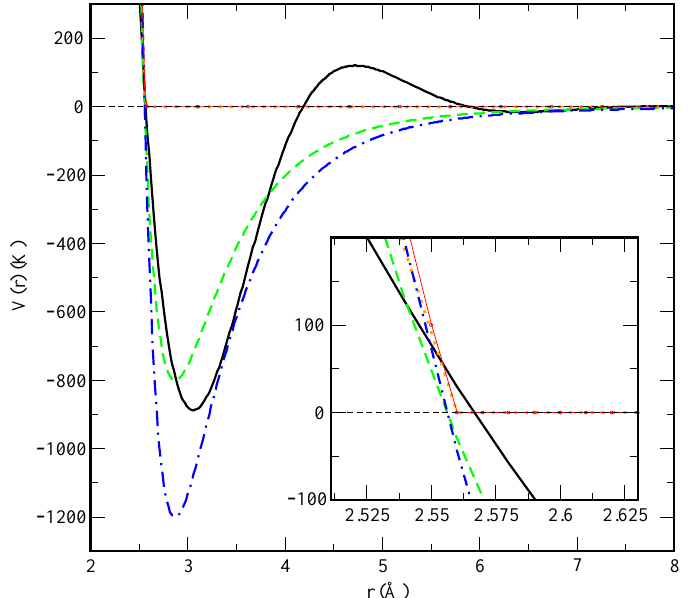
Figure 2. Microscopic two-body interaction potentials employed in this work. Main figure: overall view of the interaction potentials V ( r ) . Li-Li (black line); He-He model 1 (dot-dashed blue line); He-He model 2 (dashed green line); Li-He model 1 (red circles) and Li-He model 2 (dotted orange lines). The inset represents a zoom of the “hard-wall” area at short